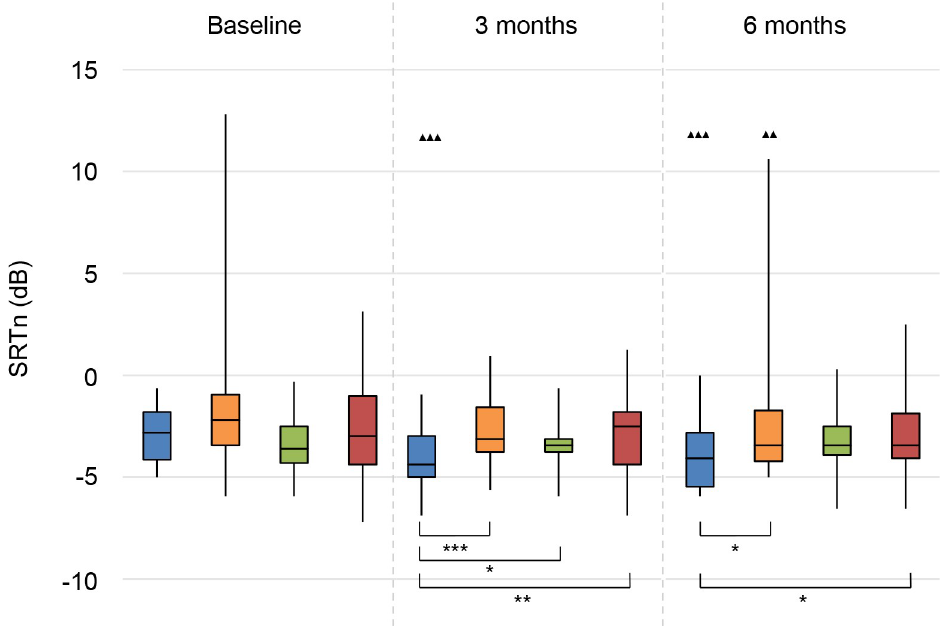
Fig 2. Speech perception in noise. Speech reception threshold in noise (SRTn) in decibels (dB), configuration S 0 N 0 . Statistical difference compared to baseline. ▲▲▲ = p < 0.001; ▲▲ = p < 0.01; ▲ = p < 0.05. Statistical difference compared to 3 months follow-up. ■■■ = p < 0.001; ■■ = p < 0.01; ■ = p < 0.05. Statistical difference between groups at same follow-up moment. ��� = p < 0.001; �� = p < 0.01; � = p < 0.05.